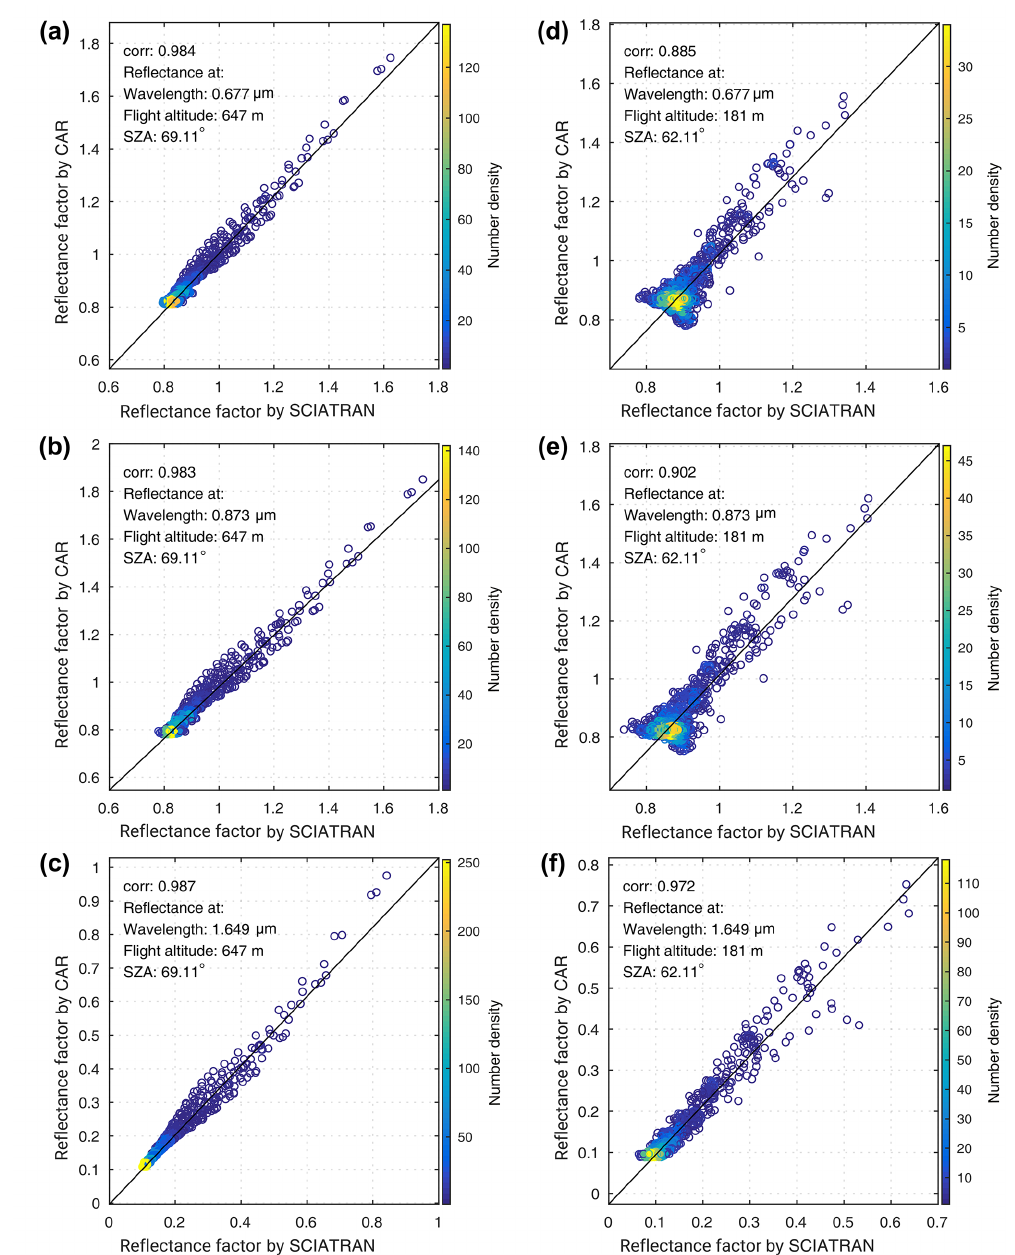
Figure 11. The scatterplot with corresponding Pearson correlation coefficient of reflectance factor measured by CAR and simulated by SCIATRAN. (a, b, c) The results for old snow and (d, e, f) fresh snow. Here the color bar represents the number density of the